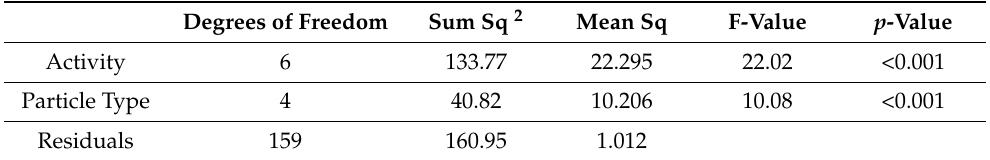
Table 2. Results of two-way ANOVA testing homogeneity of means of concentration ratios by activity and particle type after the log-transformation of the data 1 .